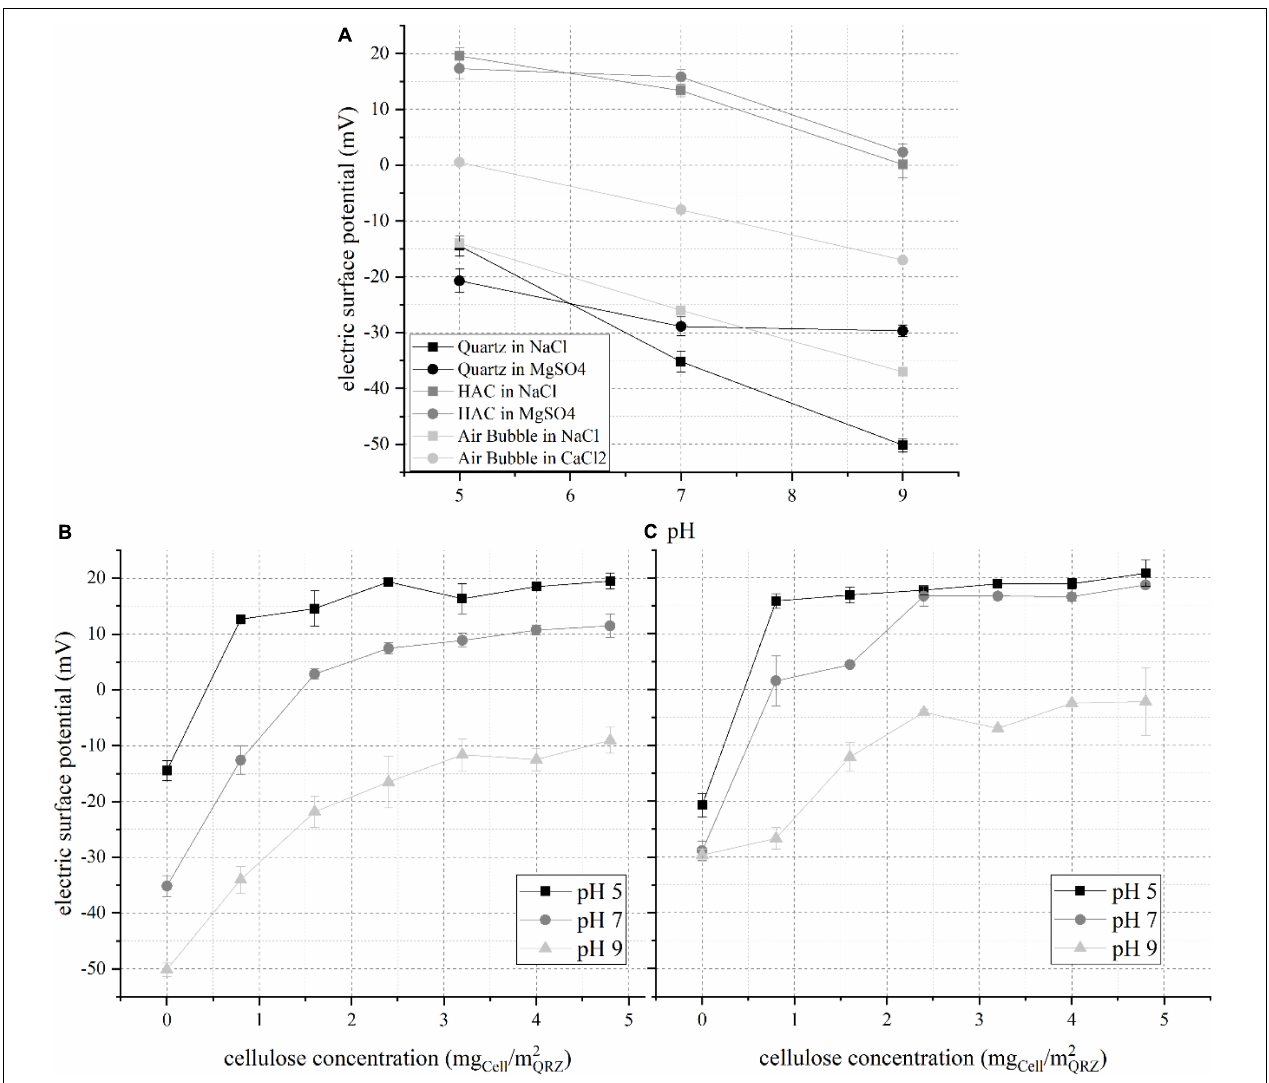
FIGURE 2 | Electric surface ( ζ − ) potential of (A) pure quartz, HAC and a bubble at different pH values according to previously published results (Yang et al., 2001; Hartmann et al., 2018), (B) QRZ at different HAC concentrations in NaCl, and (C) QRZ at different HAC concentrations in MgSO 4 ; error bars are 95% confidence intervals and lines are only visual